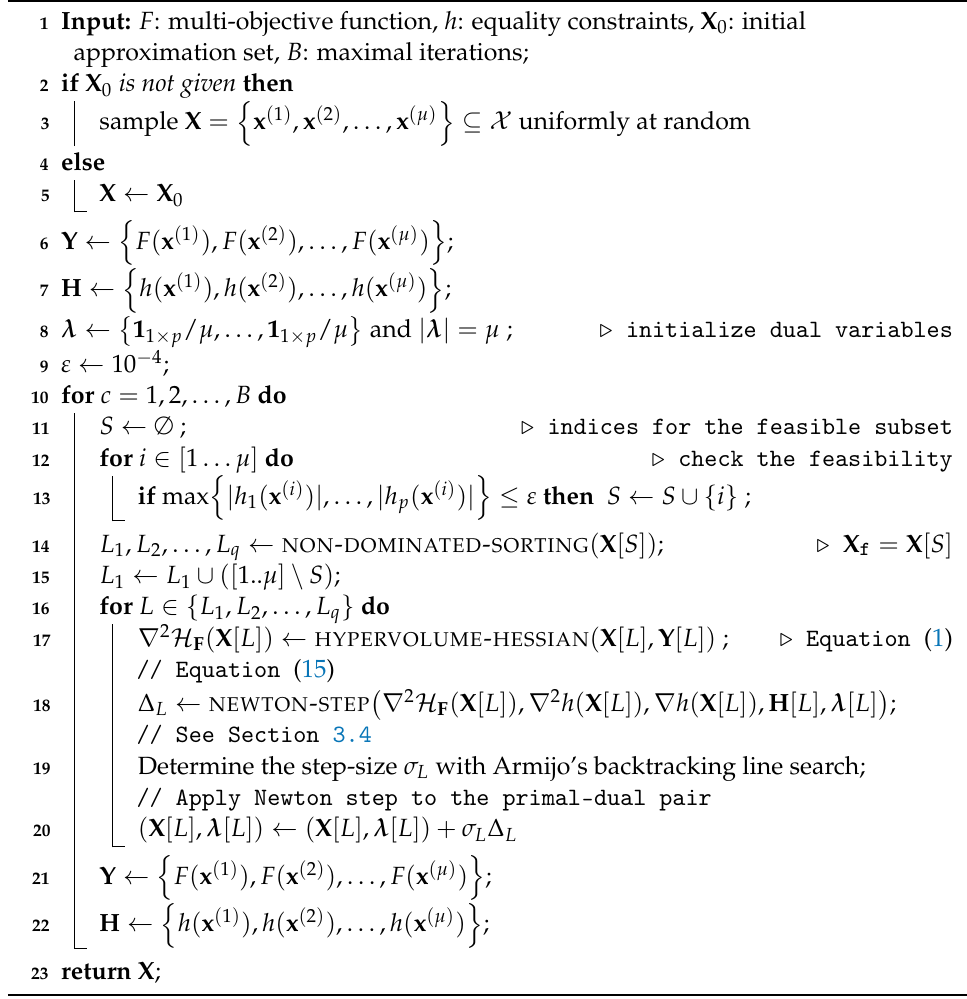
Algorithm 1: Standalone hypervolume Newton algorithm for equality- constrained